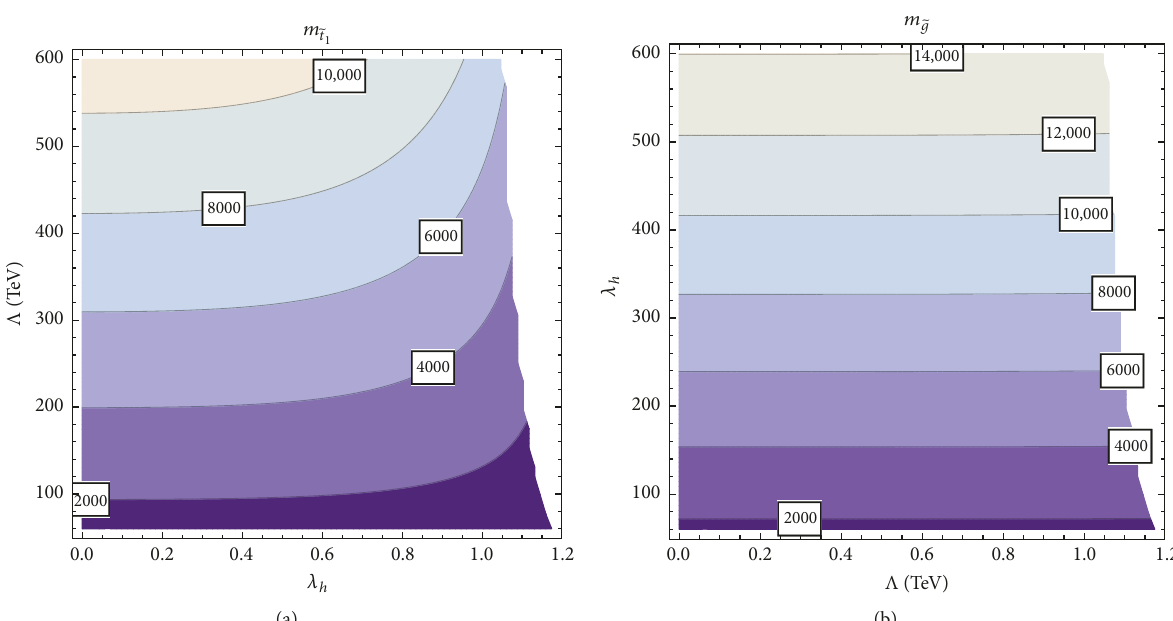
Figure 2: Distributions of stop (a) and gluino mass (b) in [𝜆 ℎ , Λ]